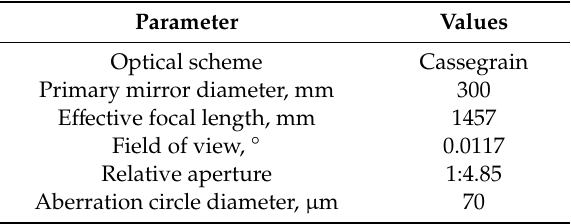
Table 3. Receiving telescope specification.